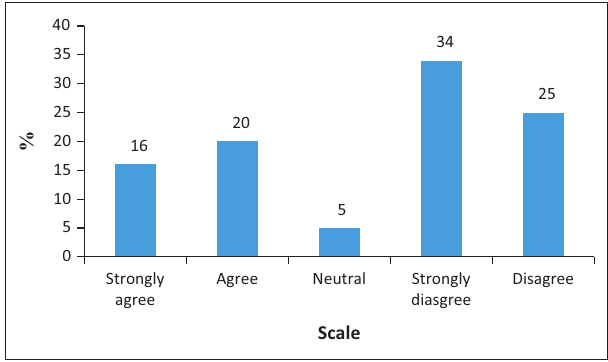
FIGURE 1: Allocating RDP houses using political